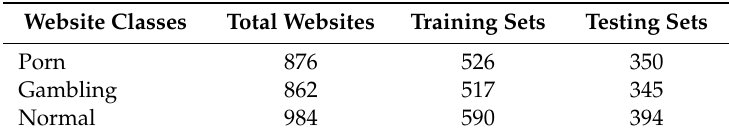
Table 1. Experimental